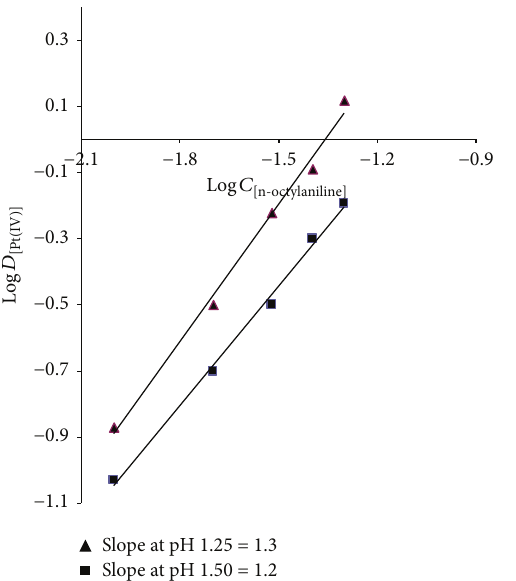
Figure 5: Log-log plot of distribution ratio 𝐷 [ at fixed ascorbate concentration. Log 𝐶 [ n-octylaniline ]